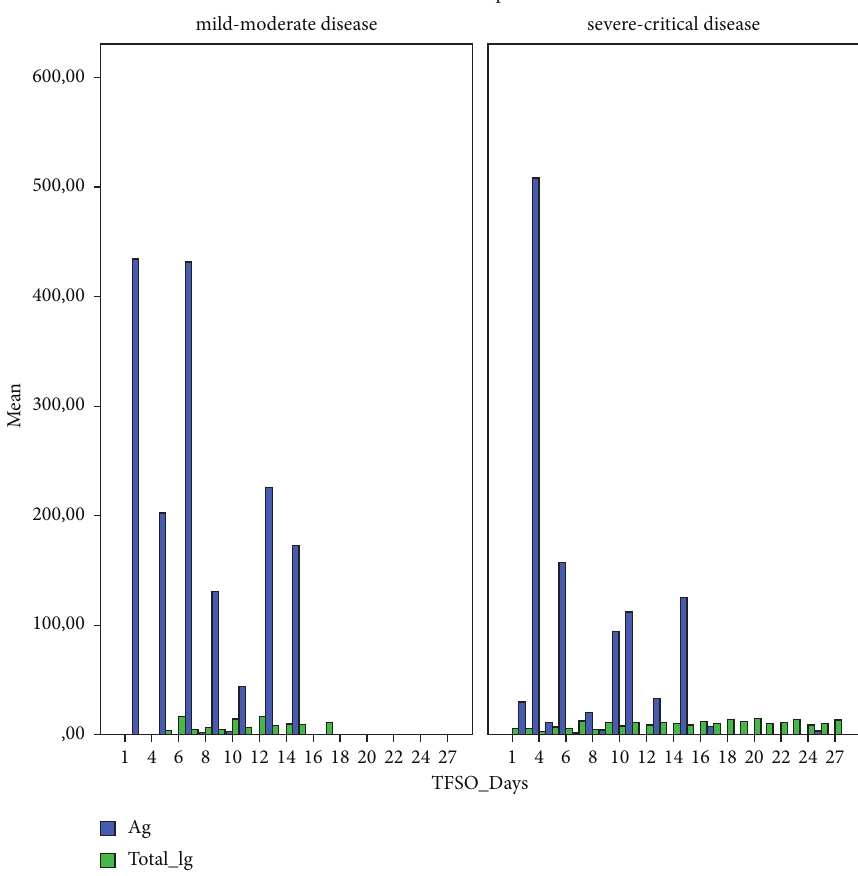
Figure 2: Mean of NP Ag and anti-S antibody titres over time in mild-moderate and severe-critical cases. TFSO: time from symptom onset